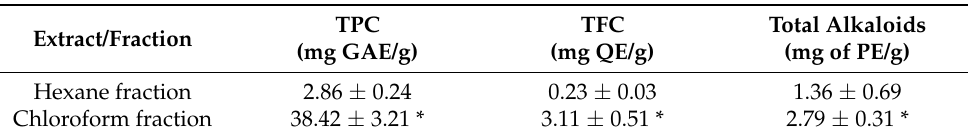
Table 6. The quantitative phenolic, flavonoid, and alkaloid contents of hexane and chloroform fractions of C. minima .